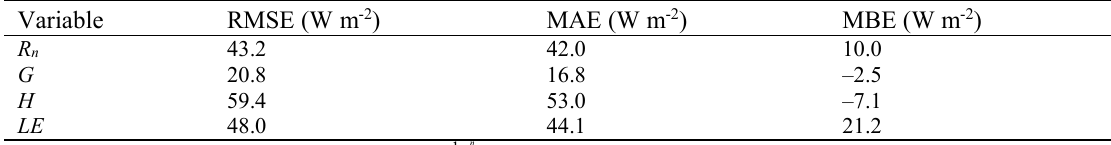
Table 1 Statistics on estimations versus ground observations .